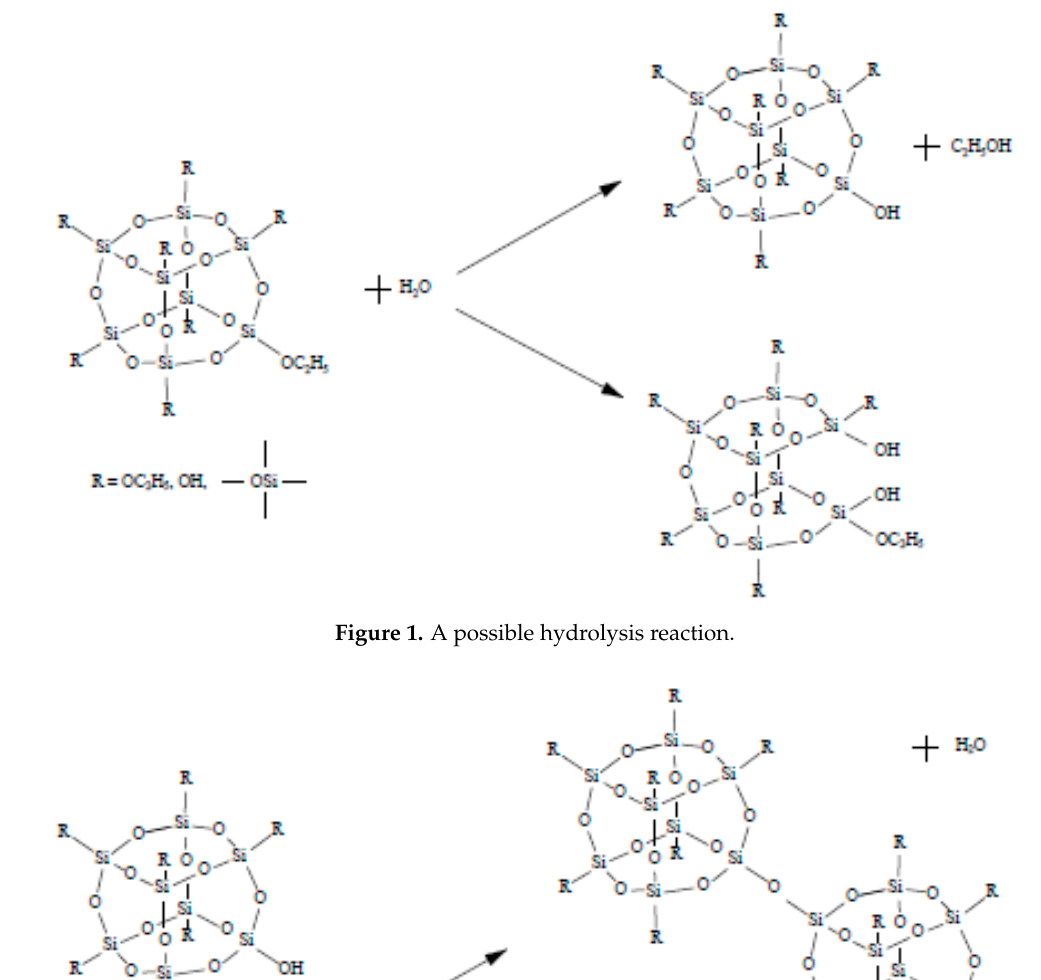
Figure 1. A possible hydrolysis reaction.